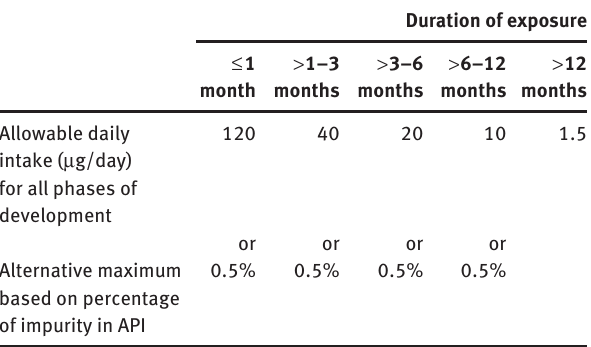
Table 7 Permissible limit for daily intake of genotoxic impurities on clinical